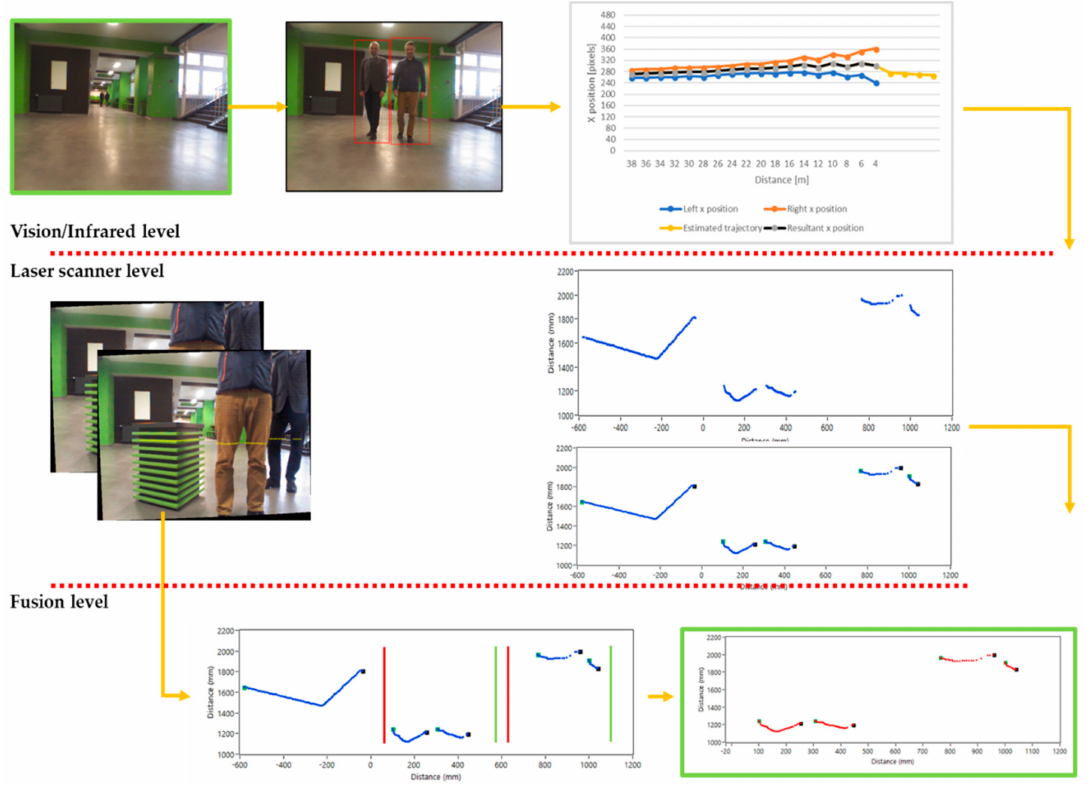
Figure 17. Simplified data flow diagram.